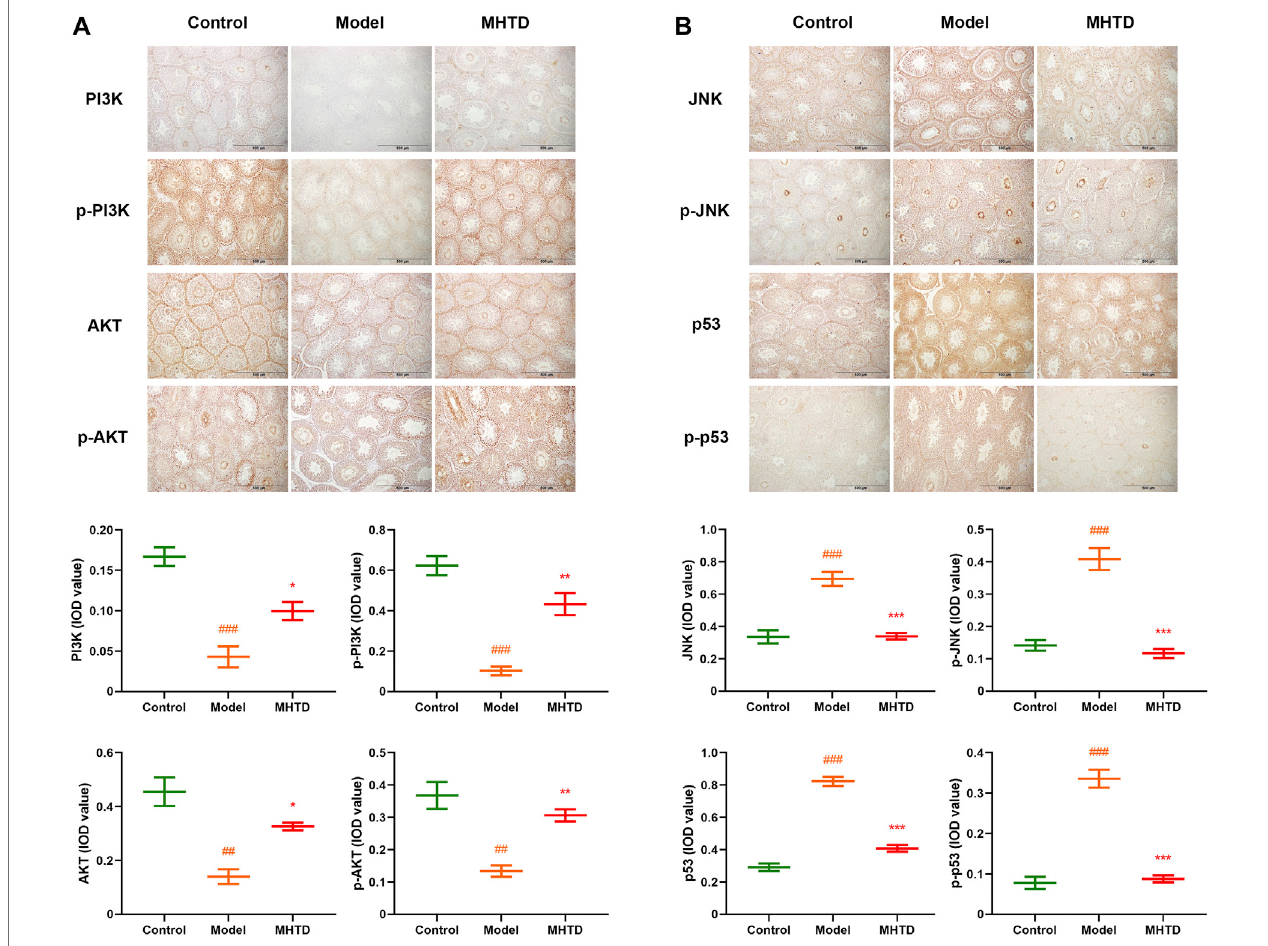
FIGURE 9 | Immunohistochemical expression of PI3K, p-PI3K, AKT, p-AKT, JNK, p-JNK, p53, and p-p53 proteins. Notes: ### p < 0.001 vs. control group; * p < 0.05, ** p < 0.01, *** p < 0.001 vs. model group.